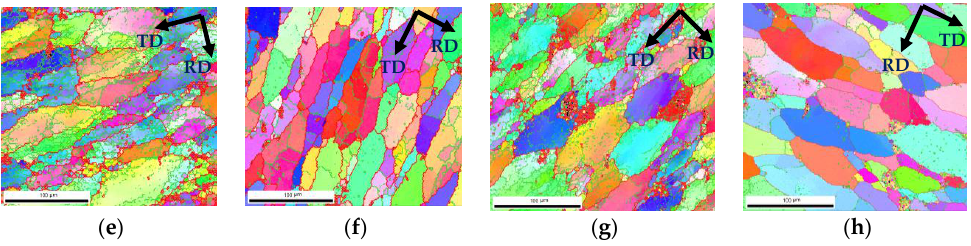
Figure 4. Typical EBSD orientation maps: ( a ) 340 °C,1 s −1 ; ( b ) 340 °C, 0.001 s −1 ; ( c ) 380 °C, 1 s −1 ; ( d ) 380 °C, 0.001 s −1 ; ( e ) 420 °C, 1 s −1 ; ( f ) 420 °C, 0.001 s −1 ; ( g ) 460 °C, 1 s −1 ; and ( h ) 460 °C, 0.001 s −1 .